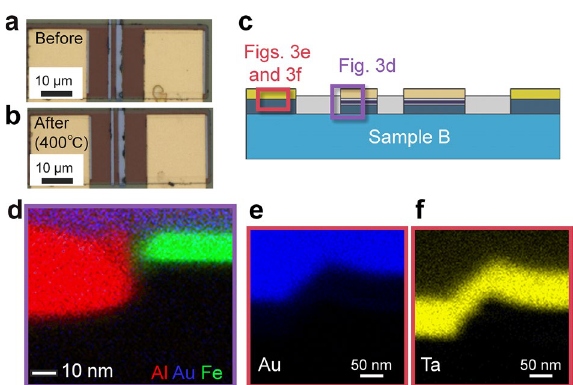
Figure 5. Microscopic pictures of sample B after annealing at 400 °C. ( a , b ) Optical microscopic image ( a ) before and ( b ) after annealing at 400 °C. ( c ) A schematic cross-section of sample B. The areas of EDS observations are roughly indicated by purple and red squares. ( d ) Elemental mapping image near the FM electrode indicated by the purple rectangle in (c), where Al, Au and Fe are shown in red, blue and green, respectively. ( e , f ) Elemental mapping images of ( e ) Au and ( f ) Ta near the NM electrode indicated by the red rectangle in